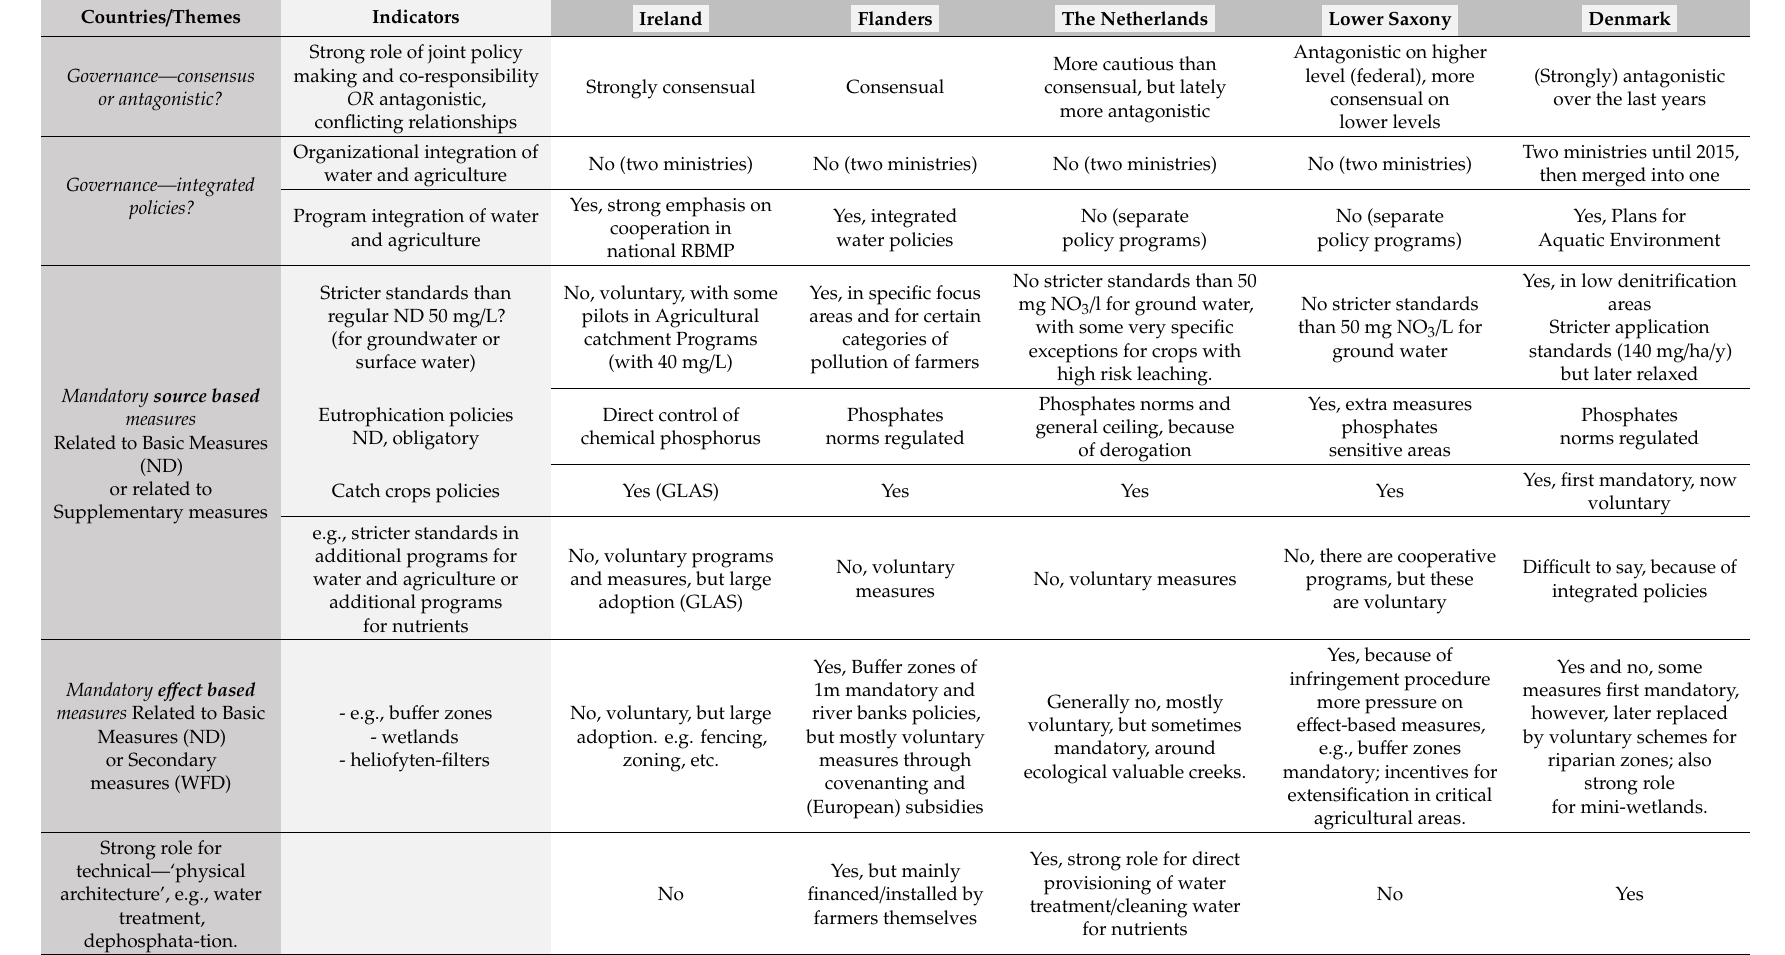
Table 1. Overview of governance characteristics and nature of measures in five